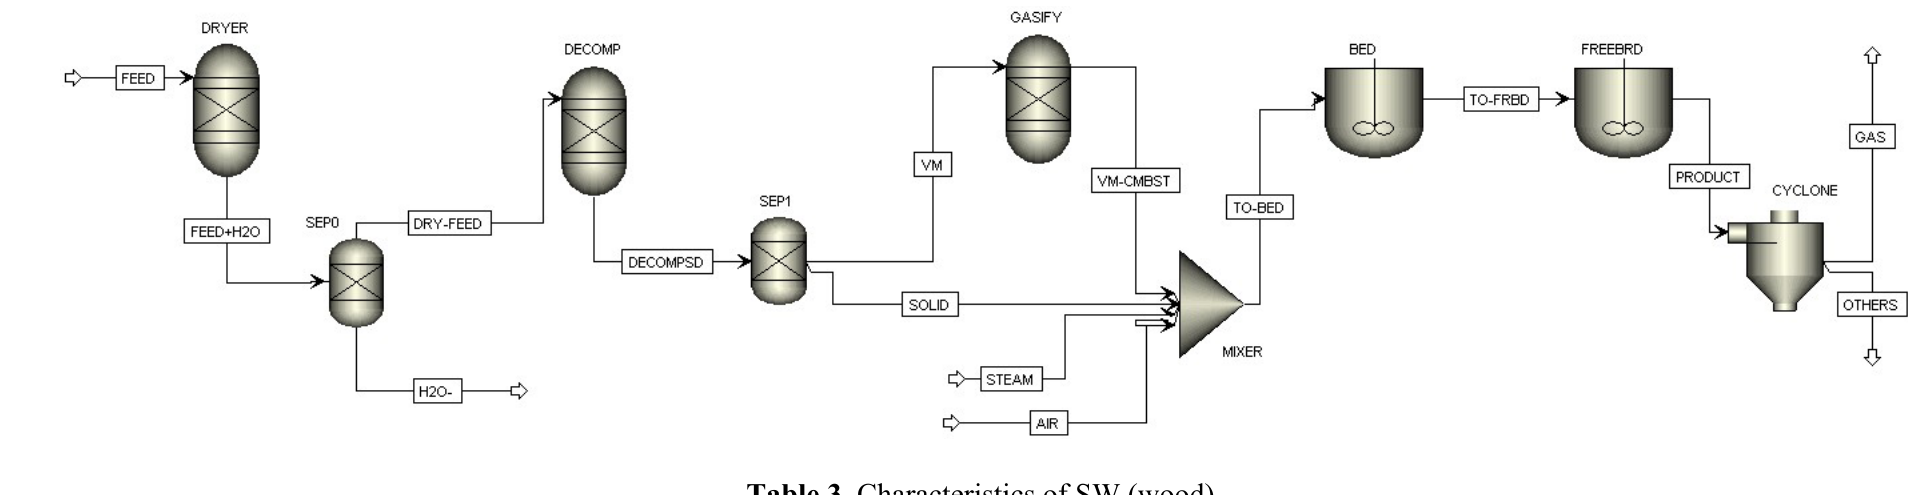
Table 3. Characteristics of SW